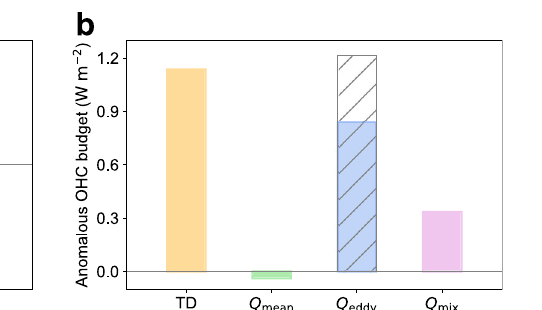
transport convergence by mesoscale eddies with the contribution of vertical eddy heat transport at 800m marked by hatched lines, and Q mix the parameterized turbulent vertical mixing. b Same as a , but for the anomalous OHC budget under greenhouse warming (i.e., 2071 – 2100 minus 1992 – 2021).